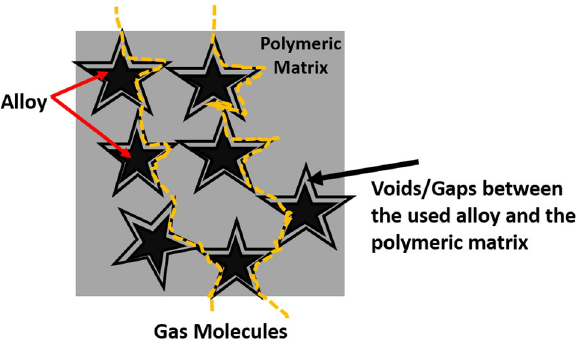
Figure 17. Schematic Diagram illustrate the role of the gabs surrounding the